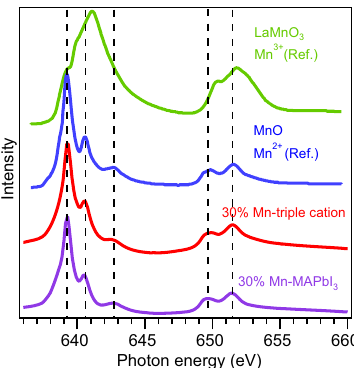
Fig. 1 Identi fi cation of Mn valence states using X-ray absorption spectroscopy (XAS). Mn L 2,3 XAS spectra measured in total electron yield mode of a MAMn 0.3 Pb 0.7 I 3 and triple-cation fi lm with 30% Mn-doping in comparison with the reference spectra for Mn 2 + from MnO and Mn 3 + from LaMnO 3 by Vasiliev et al. (shifted by 1.44 eV) 13